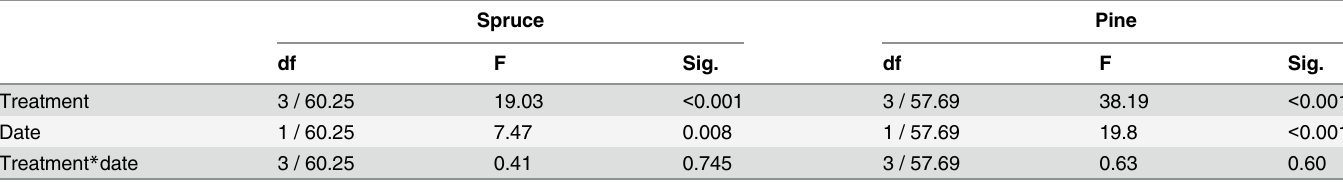
Table 2. Statistical significance tests (linear mixed model for treatment, date and their interaction) for proportion of healthy spruce and pine seed- lings in June and July. Spruce Pine df F Sig. df Sig.